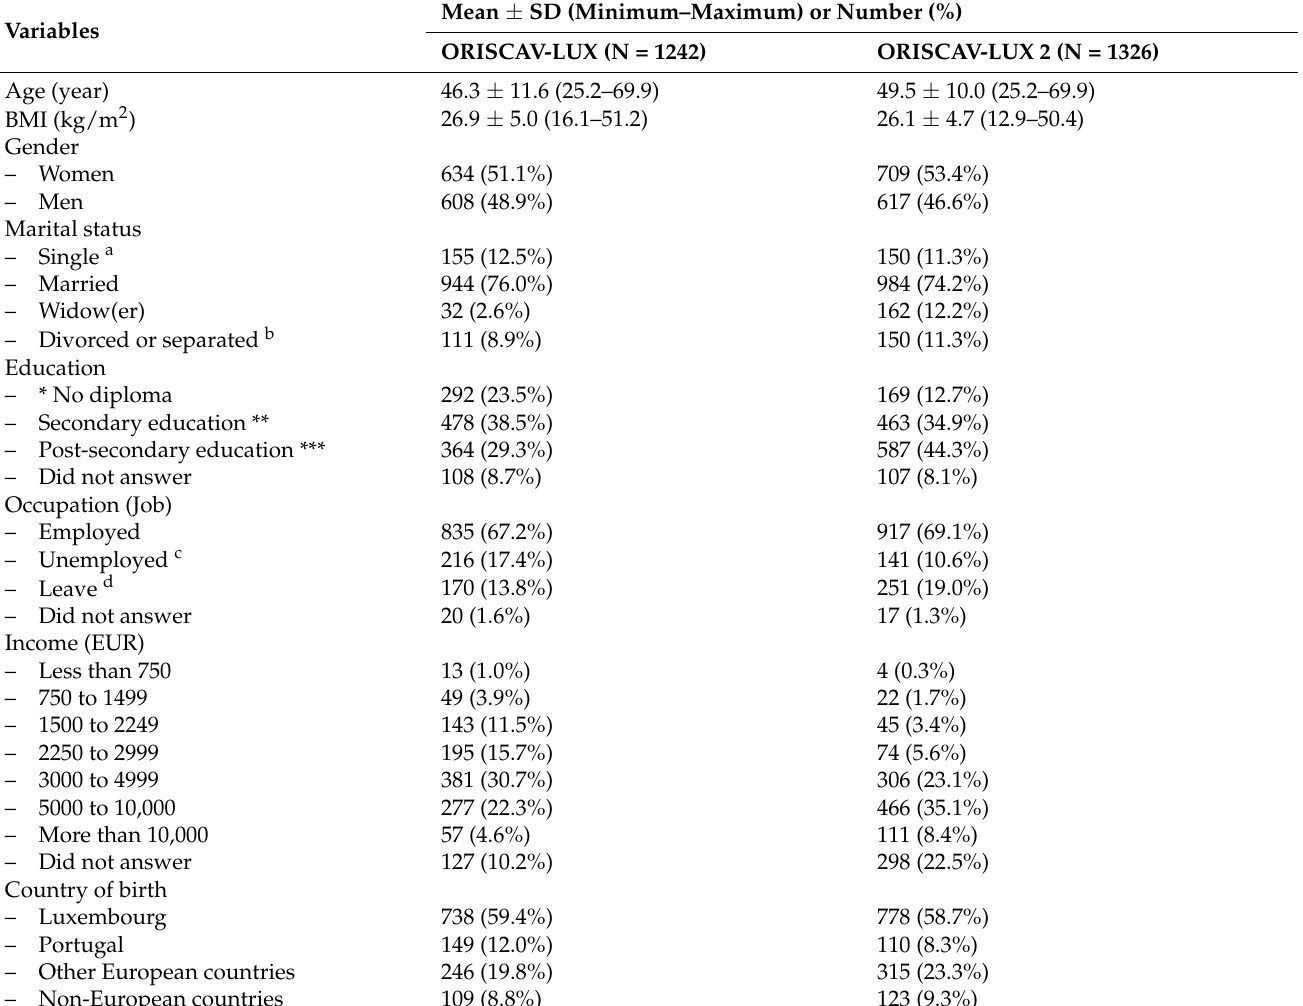
Table 1. Distribution of demographic, anthropometric, and socioeconomic characteristics of